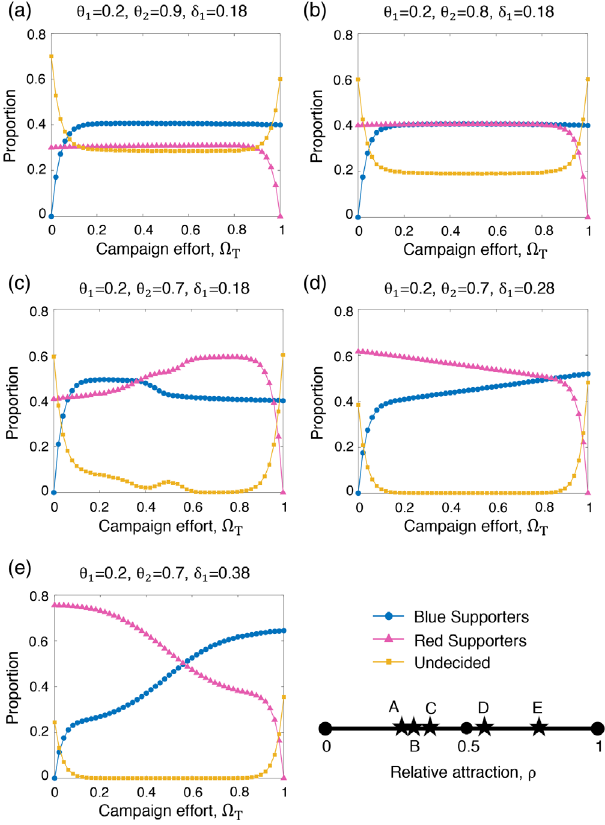
FIG. 6. Impact of campaign effort on winning majority support. (a) – (e) As the relative attraction of the viewpoints (defined as identity scope divided by candidate spread) in a campaign competition increases ( ρ ¼ 0 . 257 , 0.3, 0.36, 0.56, and 0.76, respectively), the relative efforts of campaigns become more important. In some cases, the effects of campaign effort become counterproductive [see (c)]. Parameters: All simulations